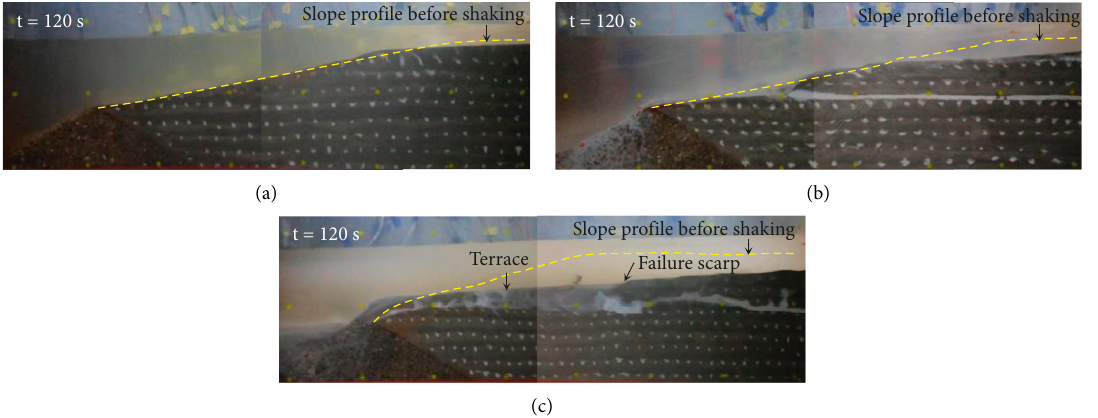
Figure 5: Snapshots of the tailings impoundment at t � 120s in (a) test T 1, (b) test T 2, and (c) test T 3.